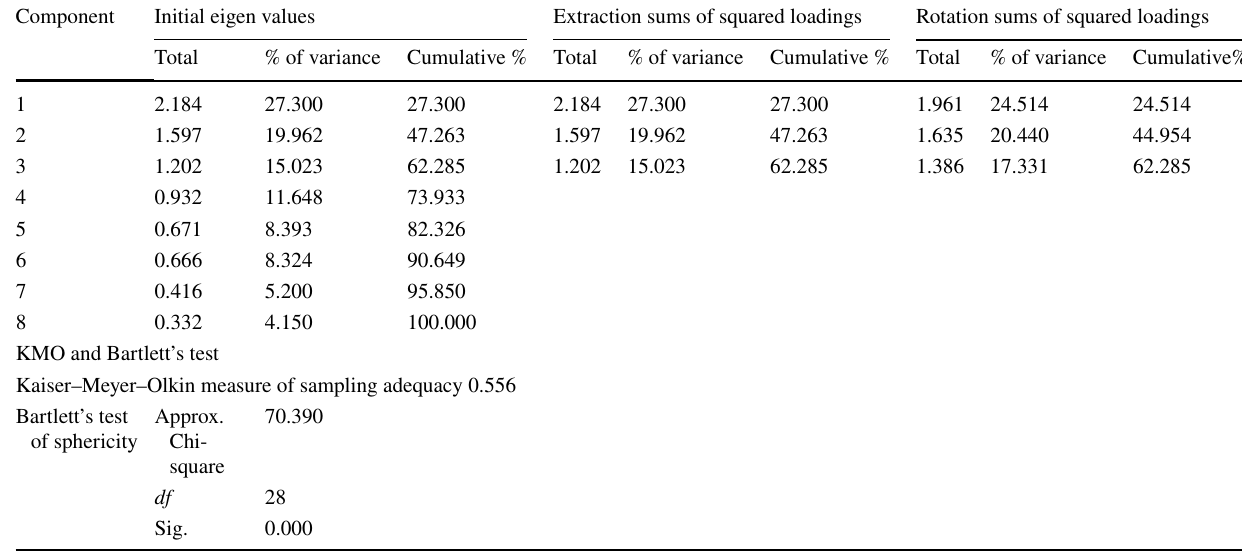
Table 11 Results of the principal component analysis for the groundwater samples during post-monsoon season, total variance explained